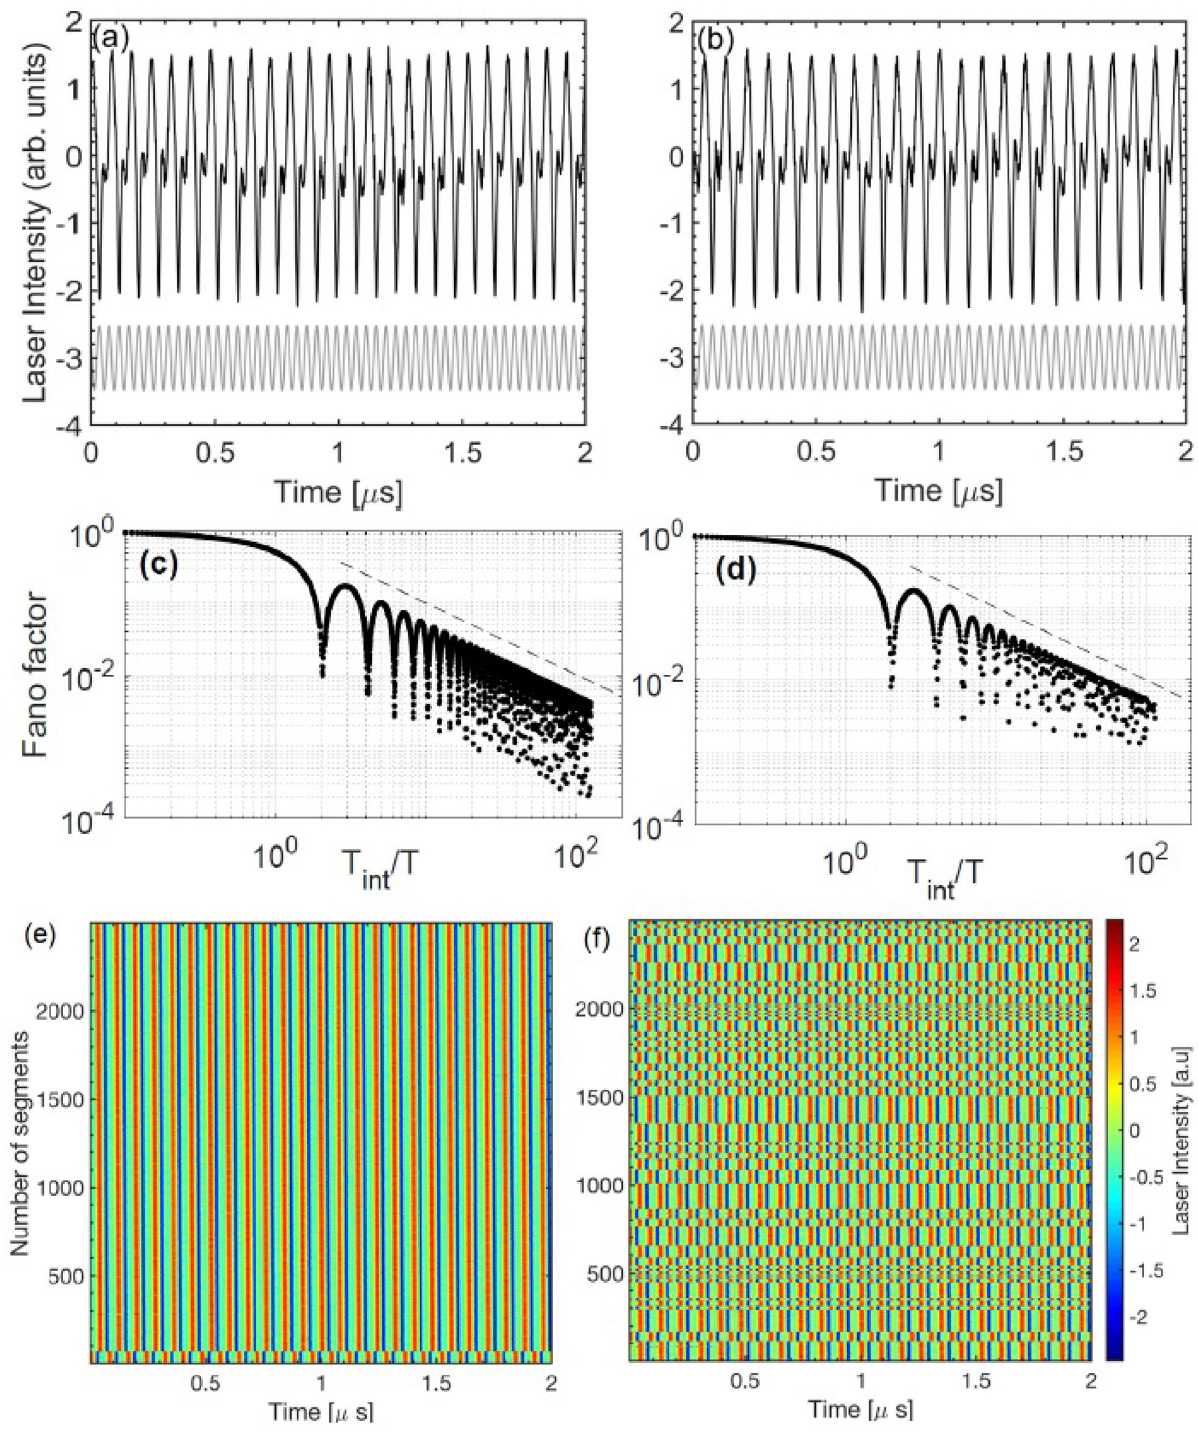
Figure 6. Comparison of different long-term locked behaviors when I dc = 26 mA and the frequency of the sinusoidal modulation is 25 MHz ( a , c , e ), 23 MHz ( b , d , f ). ( a ), ( b ) Short segment of the intensity time series; ( c ), ( d ) F versus T int / T ; ( e ), ( f ) spatio-temporal representation of the intensity time series: all the intensity values { I i , i = 1 . . . 10 7 } , are plotted in color code versus t and n such that i = n (cid:31) T + t and (cid:31) T =2 µ